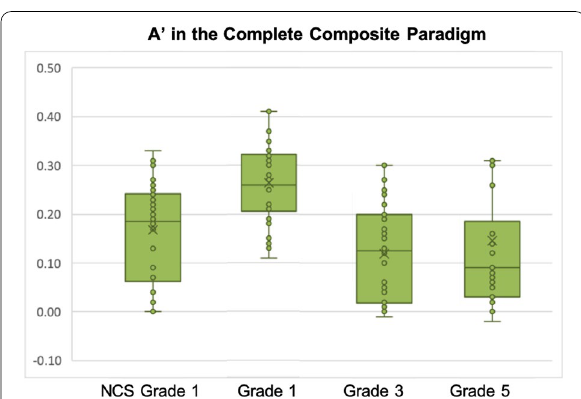
Fig. 6 Holistic A ′ in Chinese first graders, third graders, fifth graders and NCS first